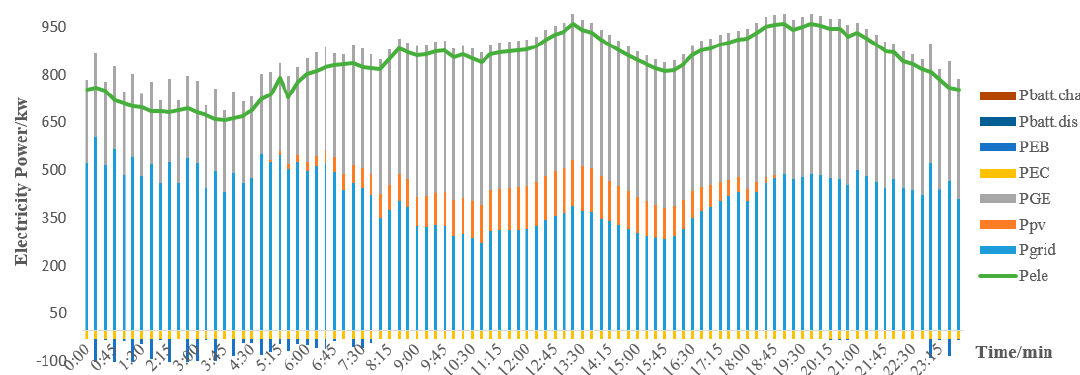
Figure 8. Power output diagram of various equipment before multi-time scale in summer.